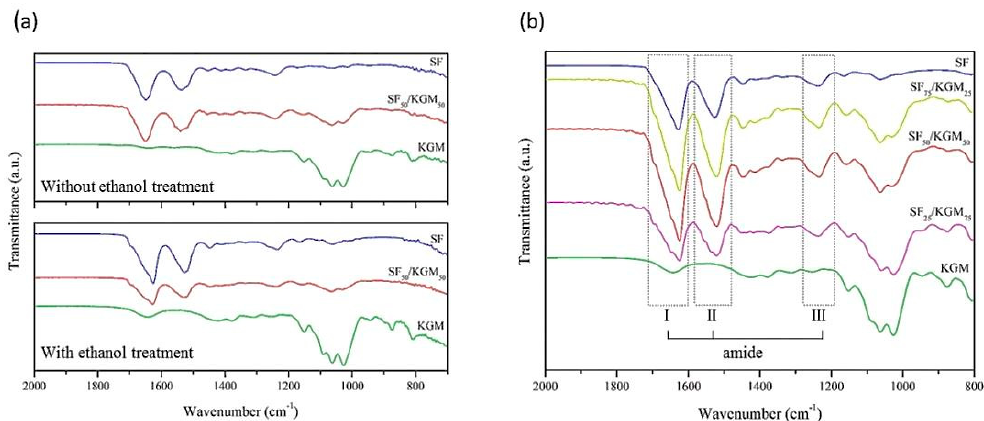
Figure 4. ( a ) FTIR ‐ ATR spectra of beads, and ( b ) FTIR ‐ ATR spectra of SF/KGM beads treated with ethanol obtained at different ratios of SF and KGM ( v / v ).